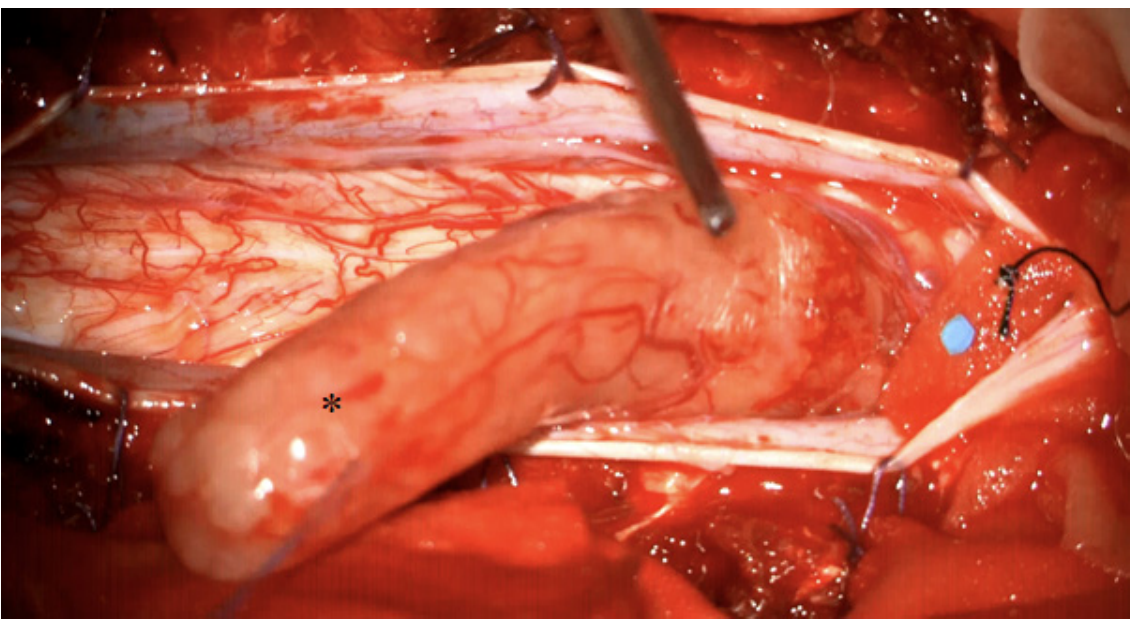
Figure 3. Intraoperative view after showing a large intradural schwannoma (marked with asterisk). The schwannoma is mobilised cranially, the compressed spinal cord is visible caudally.